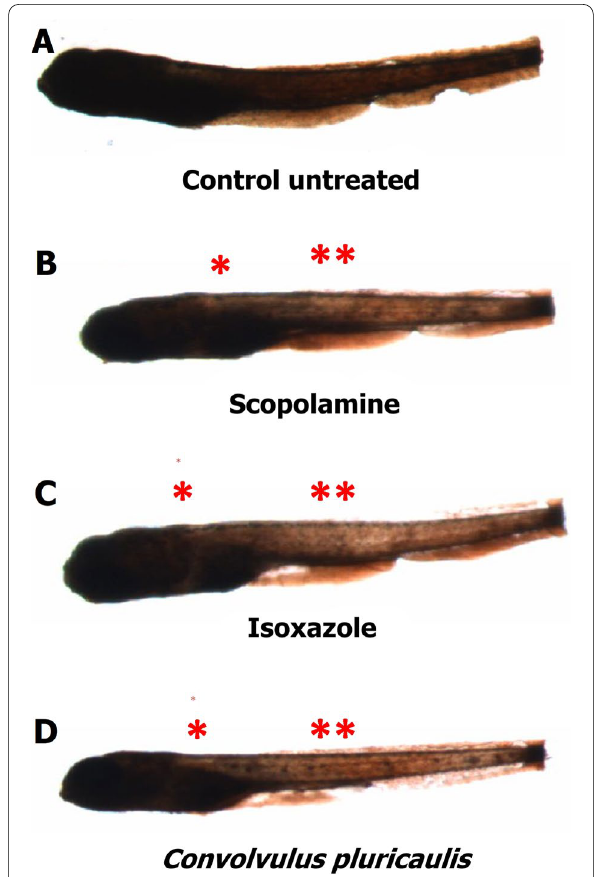
Fig. 3 Localization of acetylcholinesterase activity in larvae treated with test compounds. The AChE activity in A untreated 168 hpf larvae and larvae treated with B scopolamine, C isoxazole, and D Convolvulus pluricaulis was visualized using Karnovsky–Roots staining. The intensity of the brown stain is indicative of the level of AChE activity. * indicates AChE inhibition in myelencephalon and ** indicates AChE inhibition in somites containing sensory interneurons and motor units